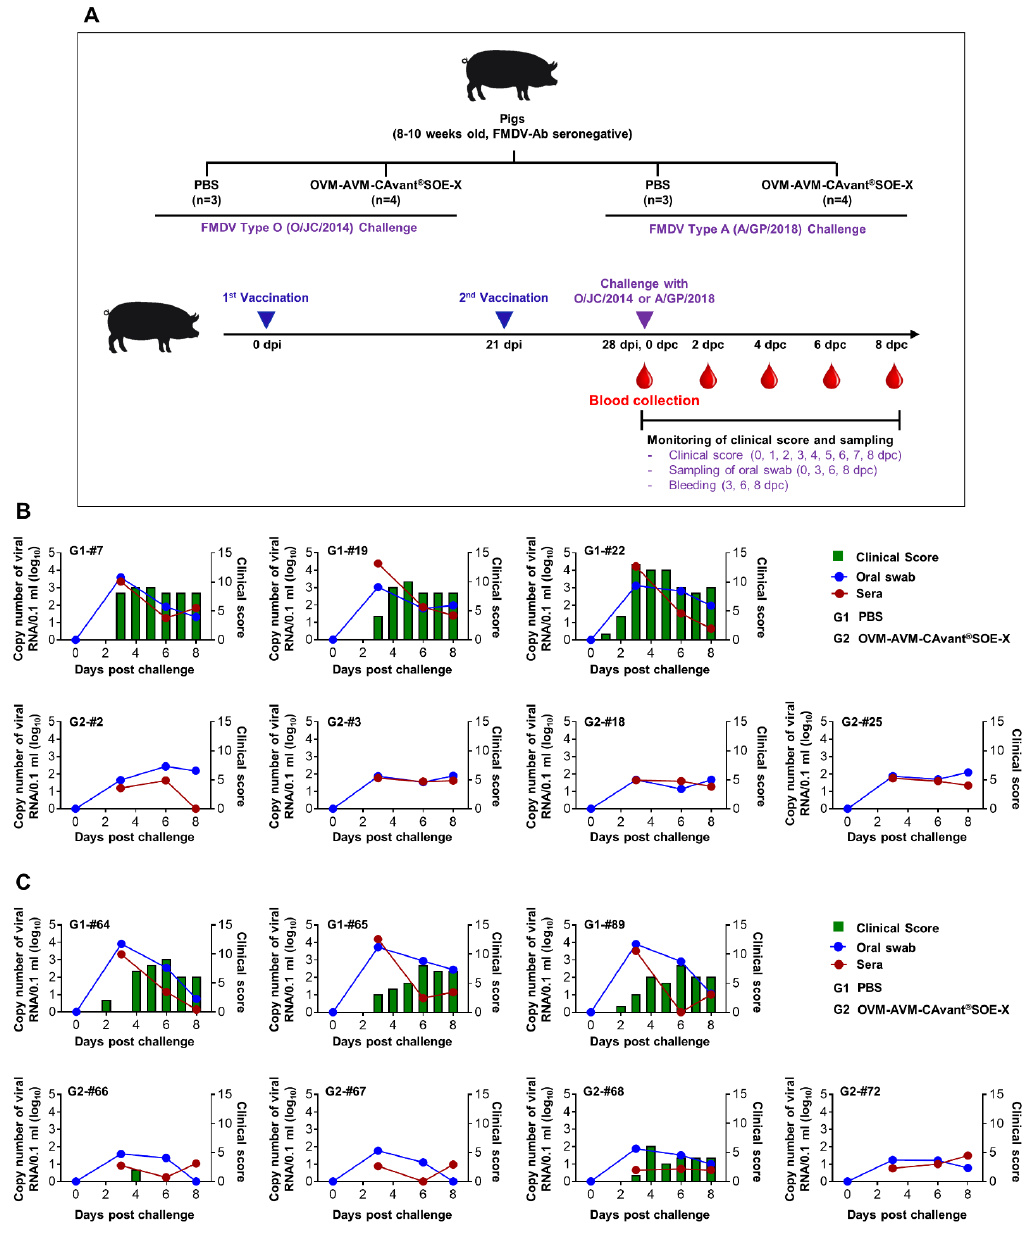
Figure 6. OVM-AVM-CAvant ® SOE-X-mediated host defense against FMDV infection in pigs. For the target animal challenge experiment, FMDV serotype O and serotype A antibody seronegative 8 – 10-week-old pigs were divided into 2 groups. The test vaccine group ( n = 4) was intramuscularly administered with 250 µg of OVM and 250 µg of AVM emulsified with CAvant ® SOE-X adjuvant. The negative control received the same volume of PBS. Vaccination was performed twice at a 21- day interval. Vaccinated animals were challenged with 10 5 TCID 50 /100 μL of O/SKR/Jincheon/2014 (O/JC/2014) or A/SKR/GP/2018 (A/GP/2008) on the heel bulb at 28 days post immunization (dpi). The clinical score and viremia in serum and oral swab were monitored for 8 days post challenge (dpc) ( A ) Schematic depiction of strategy for this study. ( B ) Clinical score and the viramia in serum and oral swab of pigs challenge with O/Jincheon/SKR/2014. ( C ) Clinical score and the amount of virus in serum and oral swab of pigs challenge with A/SKR/GP/2018. The left Y-axis of the graph shows the amount of virus in sera and oral swabs as log 10 values; the right Y-axis shows the clinical index as the maximum value of 15